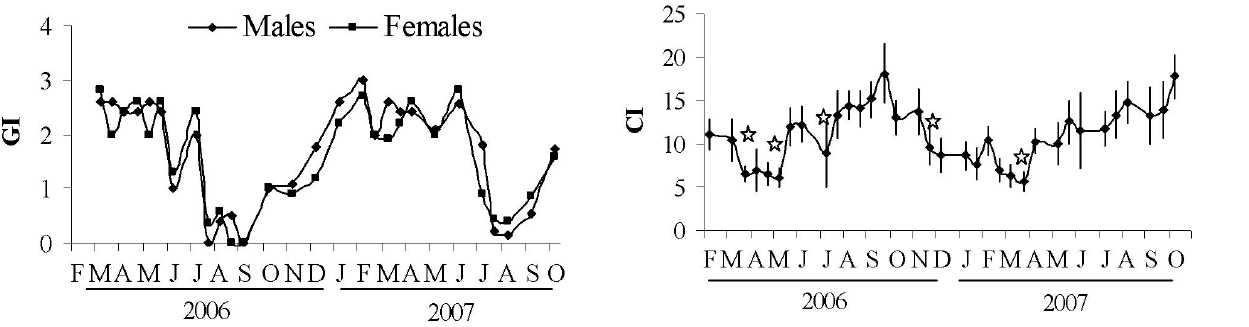
Fig . 4. – Gonad index (GI) of V. senegalensis during the experi- Fig . 6. – Mean condition index (± S.D.) in V. senegalensis dur- mental period. ing the experimental period (* statistically significant differences, P <0.05 found between consecutive